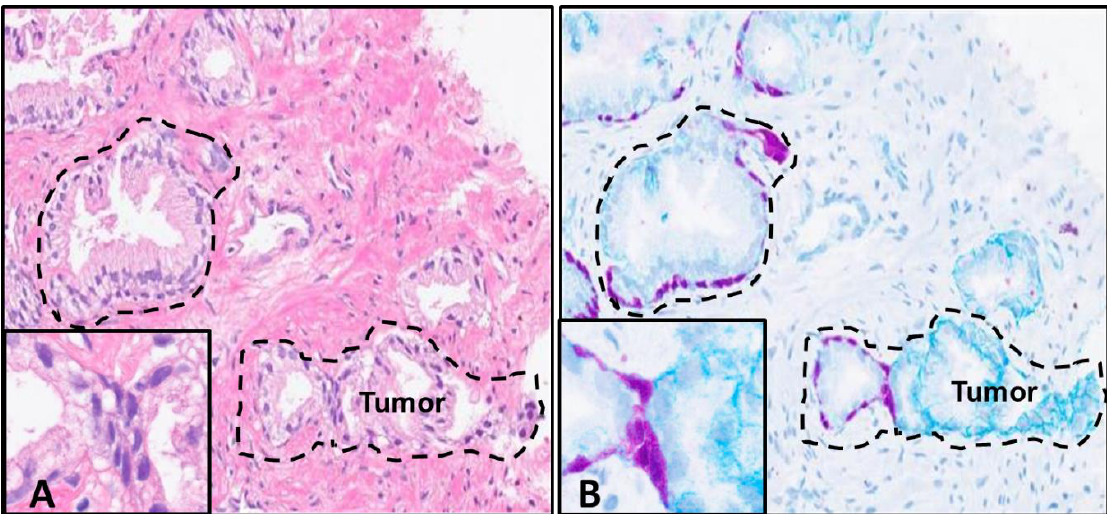
Figure 4. Prostate adenocarcinoma sample CNB H&E and Chromogen IHC. The initial H&E-stained slide with the dotted line indicating prostatic intraepithelial neoplasia (PIN) lesion and tumor area (left panel) ( A ). The de-stained H&E that was stained with HMWCK + p63 mouse monoclonal antibody cocktail and anti-CD49f rabbit polyclonal antibodies using Dual Chromogen detection (right panel) ( B ). The anti-HMWCK + p63 antibody cocktail (purple) stains the basal cells of normal prostatic glands, and the anti-CD49f (teal) antibody stains normal basal cell membranes (masked by the HMWCK + p63) but demonstrates an intracellular and cytoplasmic expression in aggressive tumors (area demonstrating budding tumor outlined in H&E-stained slide in the left panel and the right panel) (20 × magnification with 60 × instep]).